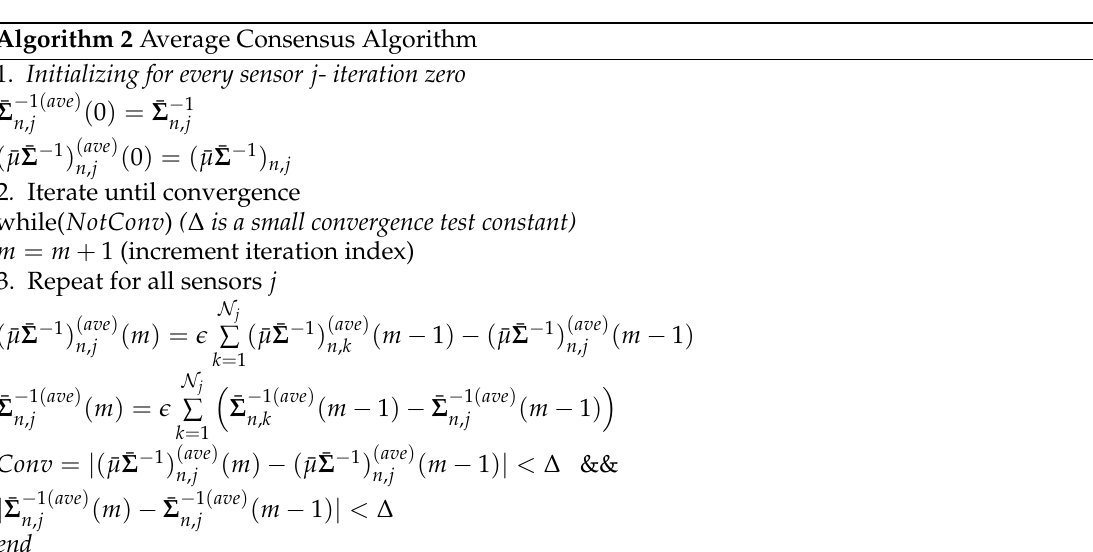
Algorithm 2 Average Consensus